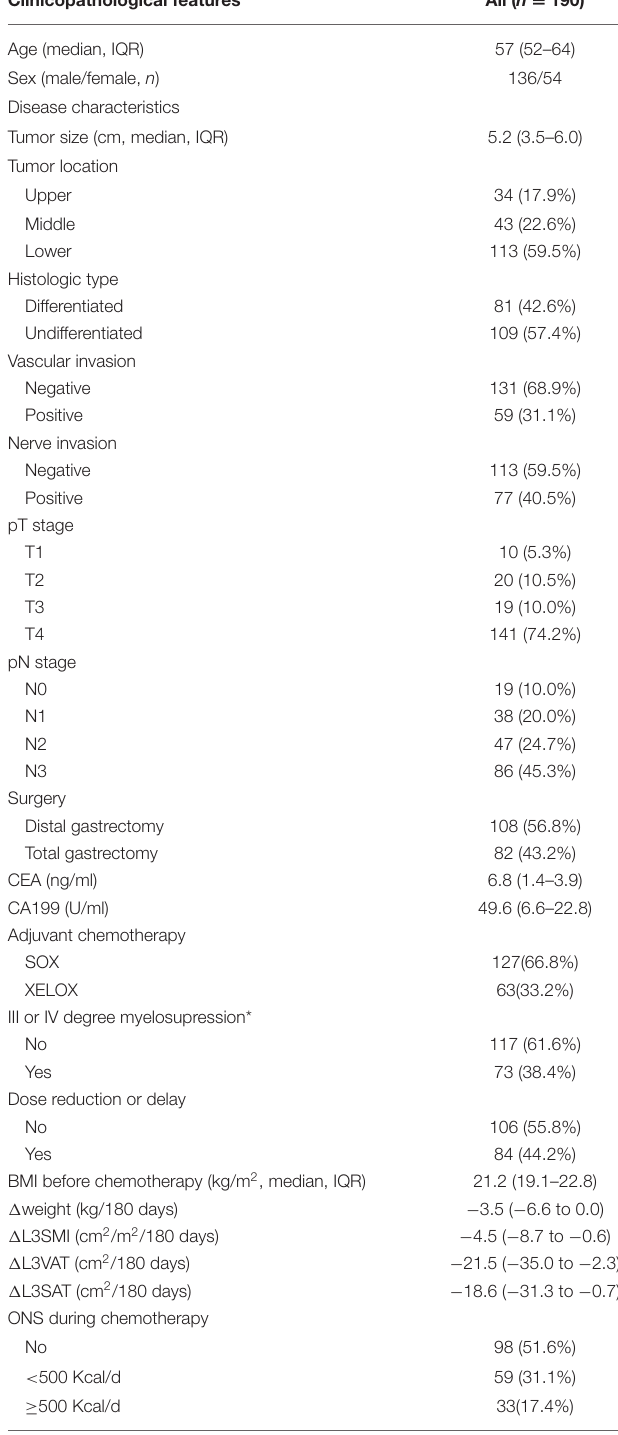
TABLE 1 | Patient